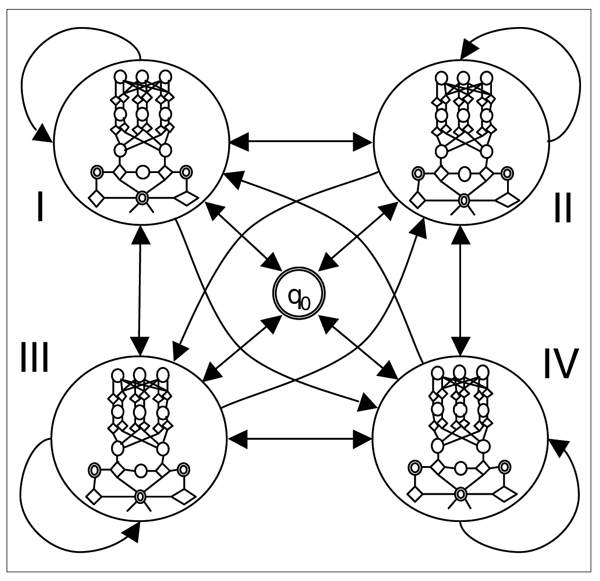
HMM for predicting isochore boundaries. States are shown as large circles, with transitions indicated by directed arrows. Transition probabilities are omitted for clarity. Within each outer state is a GHMM profile. States represent isochores, or discrete ranges of G+C density: I = (0,43%), II = (43-51%), III = (51-57%), and IV = (57-100%).